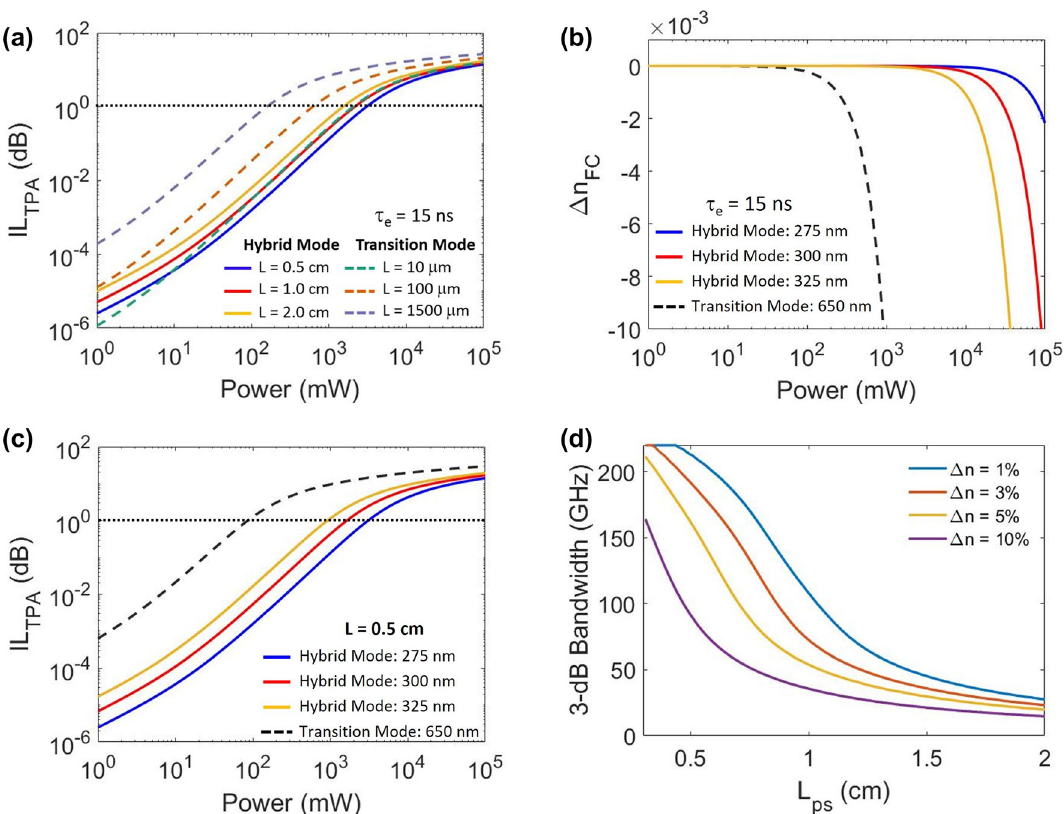
Figure 2. ( a ) The calculated insertion loss (IL) due to TPA as a function of peak optical power in the hybrid waveguide mode (solid) and the transition mode (dashed) assuming different lengths of the phase-shift segment. ( b ) The change in refractive index due to the additional free carriers generated via TPA as a function of peak optical power for the hybrid and transition modes. ( c ) The calculated IL due to TPA as a function of peak optical power in the hybrid (solid) and transition (dashed) mode assuming a length of 0.5 cm for different waveguide widths. ( d ) The calculated 3-dB bandwidth of a traveling-wave MZM as a function of L ps assuming impedance matching to a 50 (cid:31) load, and for different values of the index mismatch, (cid:31) n mo . WG, waveguide; TFLN, thin-film lithium